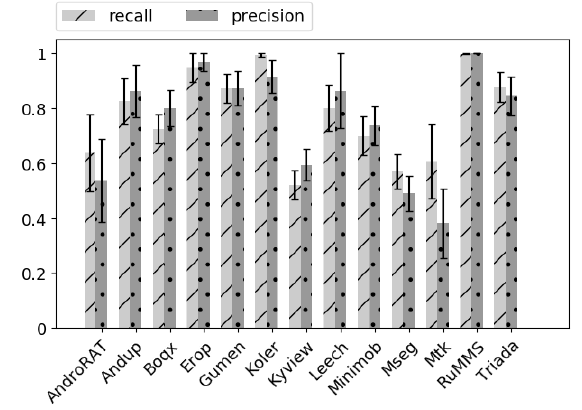
Figure 7. Precision and recall for each class in the AMD